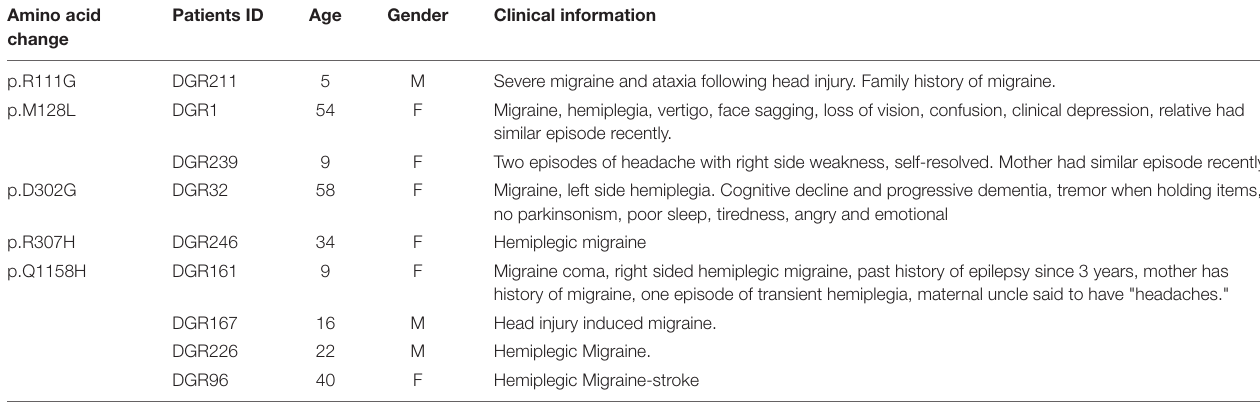
TABLE 2 | Clinical manifestation of nine cases with five extracellular variants in CACNA1I